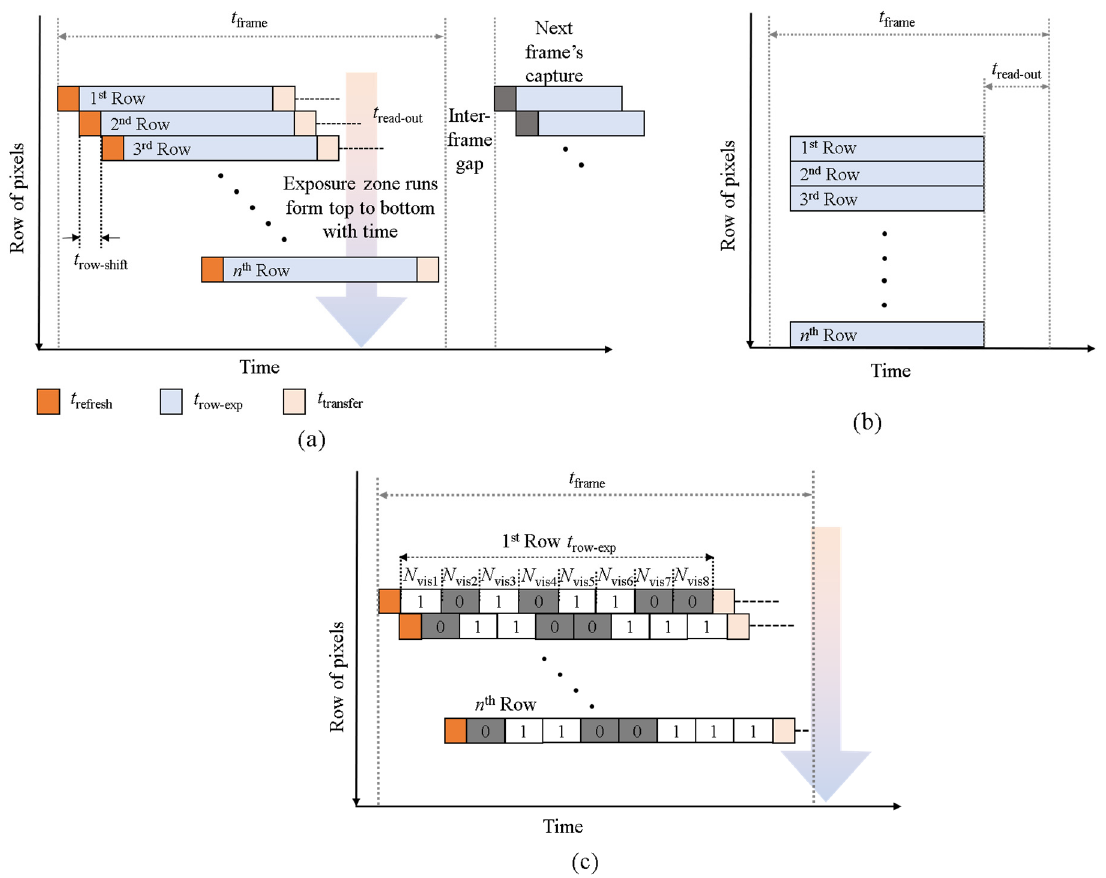
Figure 4. The camera capturing modes in OCC: ( a ) traditional rolling-shutter (RS) mechanism, ( b ) global-shutter (GS); and ( c ) RS-based capturing of the proposed multi-channel Tx.